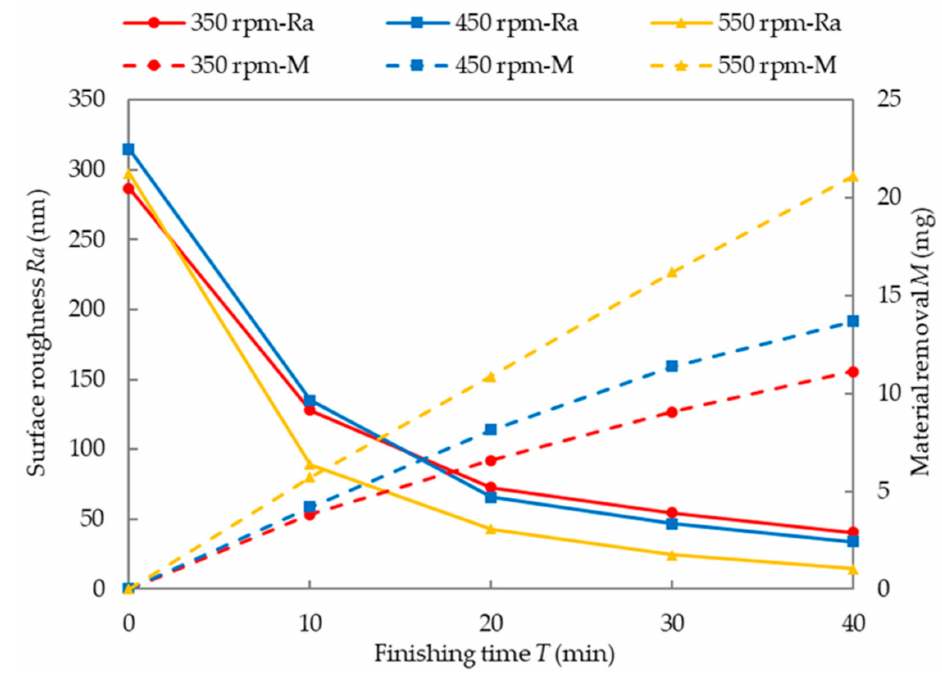
Figure 16. The e ff ect of rotational speed on surface roughness and material removal.